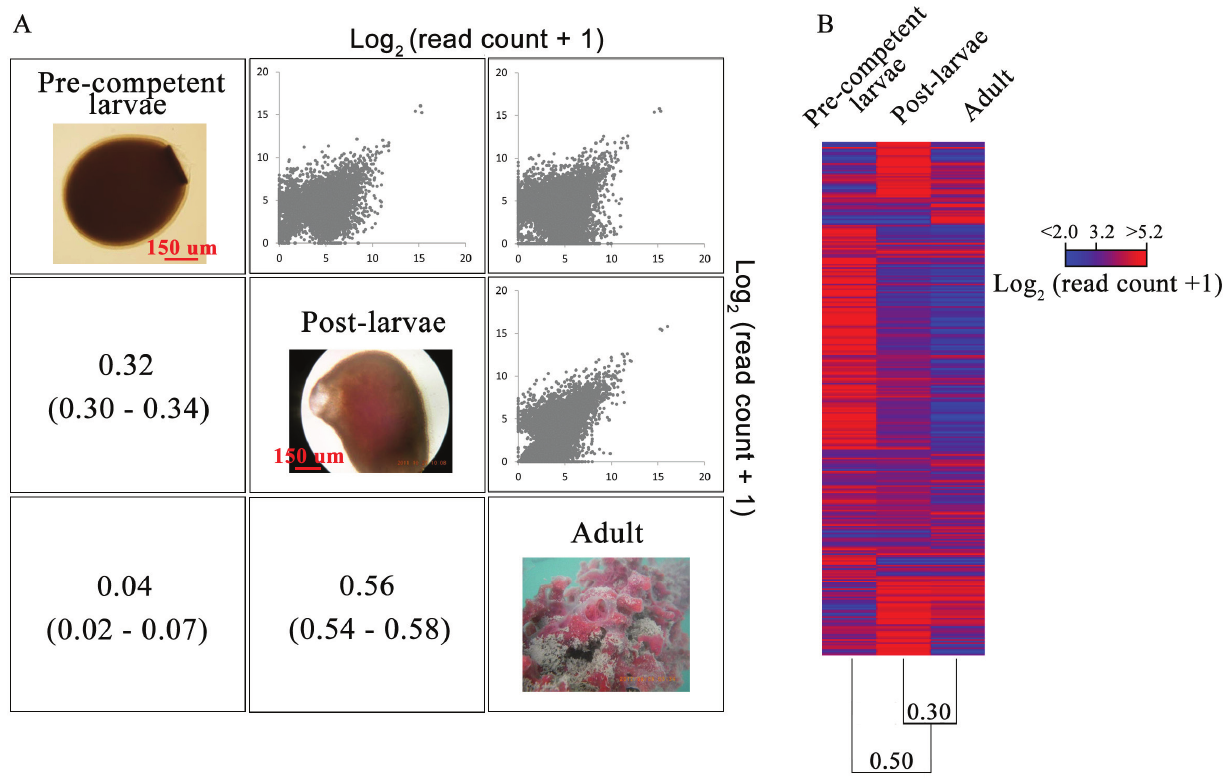
Figure 5. Profiling the life cycle transcriptome changes of M. phyllophila . ( A ) Pearson’s r s (with CIs in parentheses) and bivariate plots for the log 2 (read count + 1)’s of the 8202 contigs with (cid:2)64 reads for at least one life cycle stage (below and above the diagonal, respectively); ( B ) Heat map of the log 2 (read count + 1)’s for the subset of 3827 contigs in Figure 5A with a (cid:2)4-fold expression difference between one stage and the mean of the other two. The pairwise gene expression differences of the heat map are summarized by the UPGMA dendrogram with distance = (1 (cid:4) r